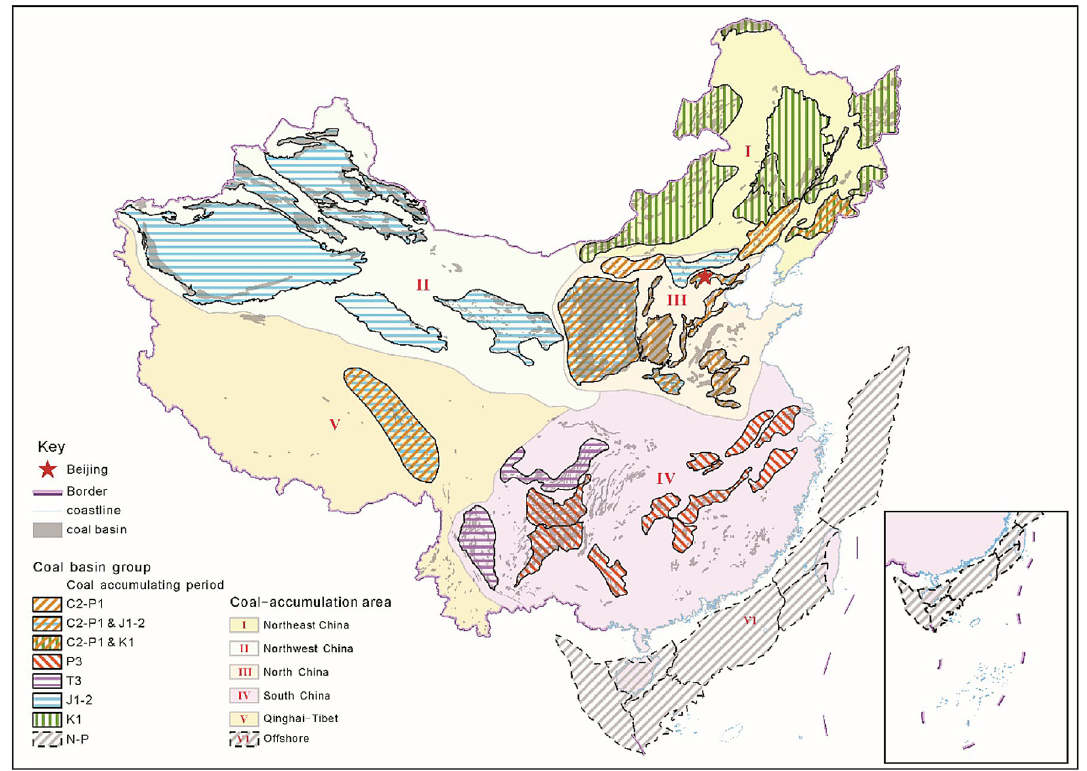
Fig. 1 Coal-accumulating areas in China (revised after Han and Yang 1980; Zhang 1995; Han 1996; Cheng 2001,